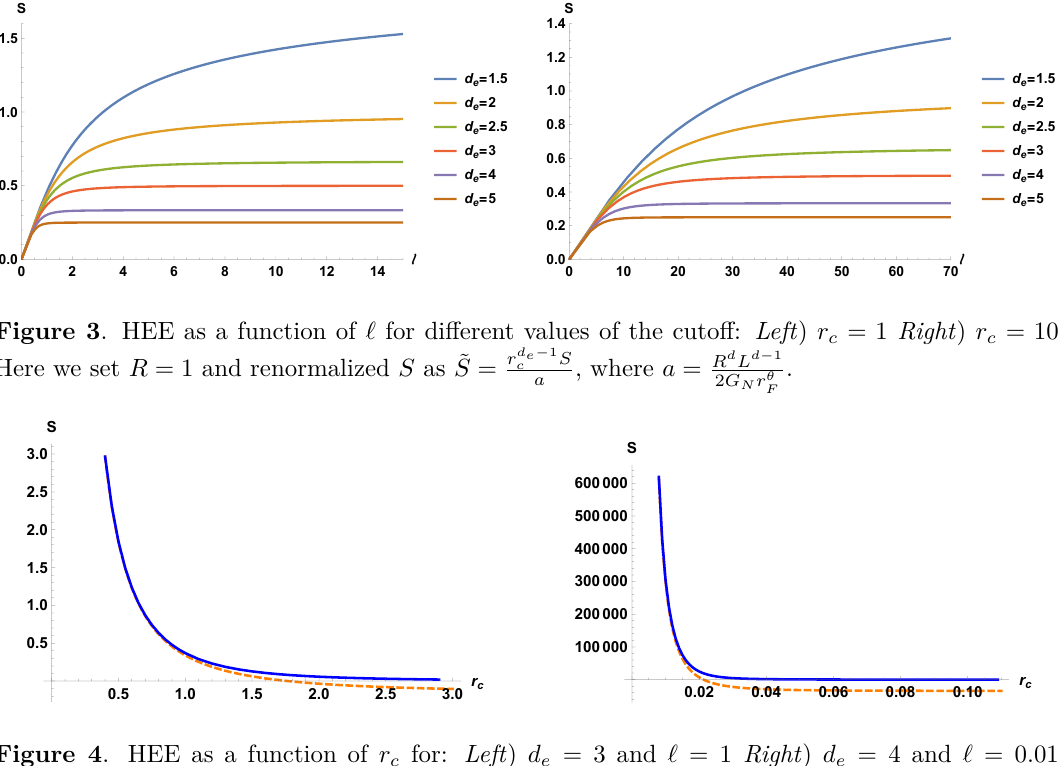
Figure 4 . HEE as a function of r c for: Left ) d e = 3 and ‘ = 1 Right ) d e = 4 and ‘ = 0 . 01 . The solid blue curves show the numerical results based on eq. (3.17) and the dashed orange curves indicate the HEE for the zero cutoff case given in eq. (3.10) which are valid for very small cutoffs, i.e. r . Here we set R = 1 and renormalized S as ˜ S = r de − 1 c S c (cid:28) ‘